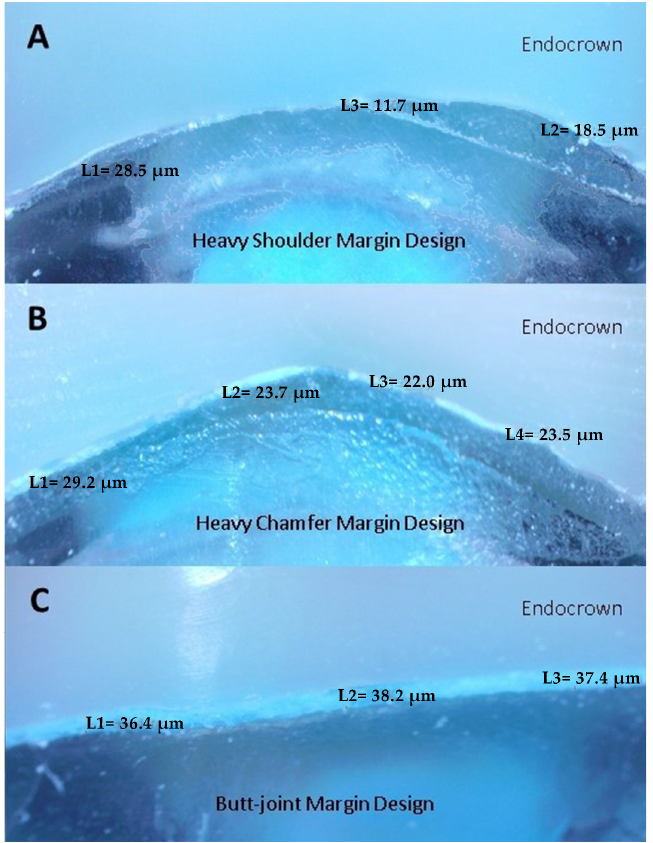
Figure 2. Example of marginal gap from the distal surface. ( A )Heavy Shoulder Margin Design ( B )Heavy Chamfer Margin Design ( C )Butt ‐ joint Margin Design. ( B ) Heavy Chamfer Margin Design ( C ) Butt-joint Margin